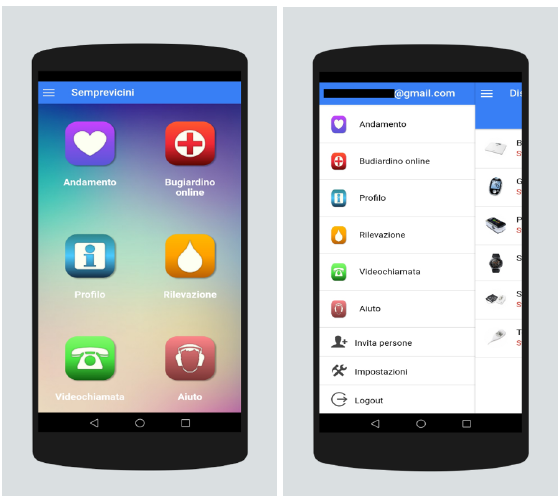
Figure 3. The Assisto eCare 4.0 mobile app (menu is in